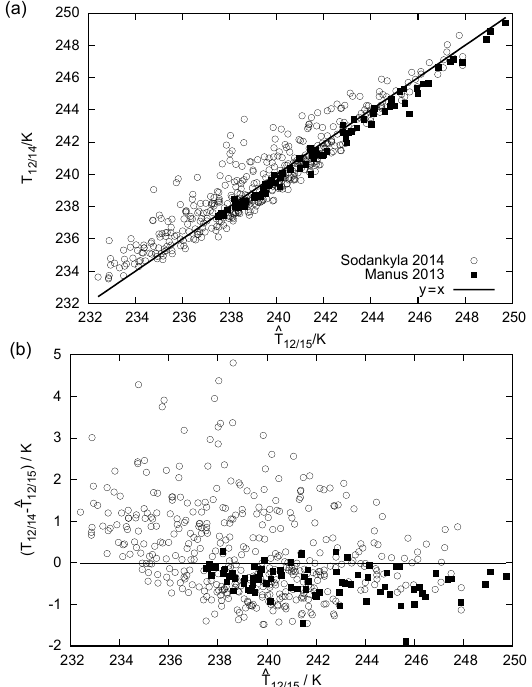
Figure 7. (a) Test of the superposition method using radiosonde profiles from the two GRUAN stations Sodankylä, Finland, and Manus, Papua New Guinea. The diagonal line ( y = x ) is included to check the result: it is not a fit. (b) The same data, plotted with the difference in T 12 / 14 − ˆ T 12 / 15 on the y